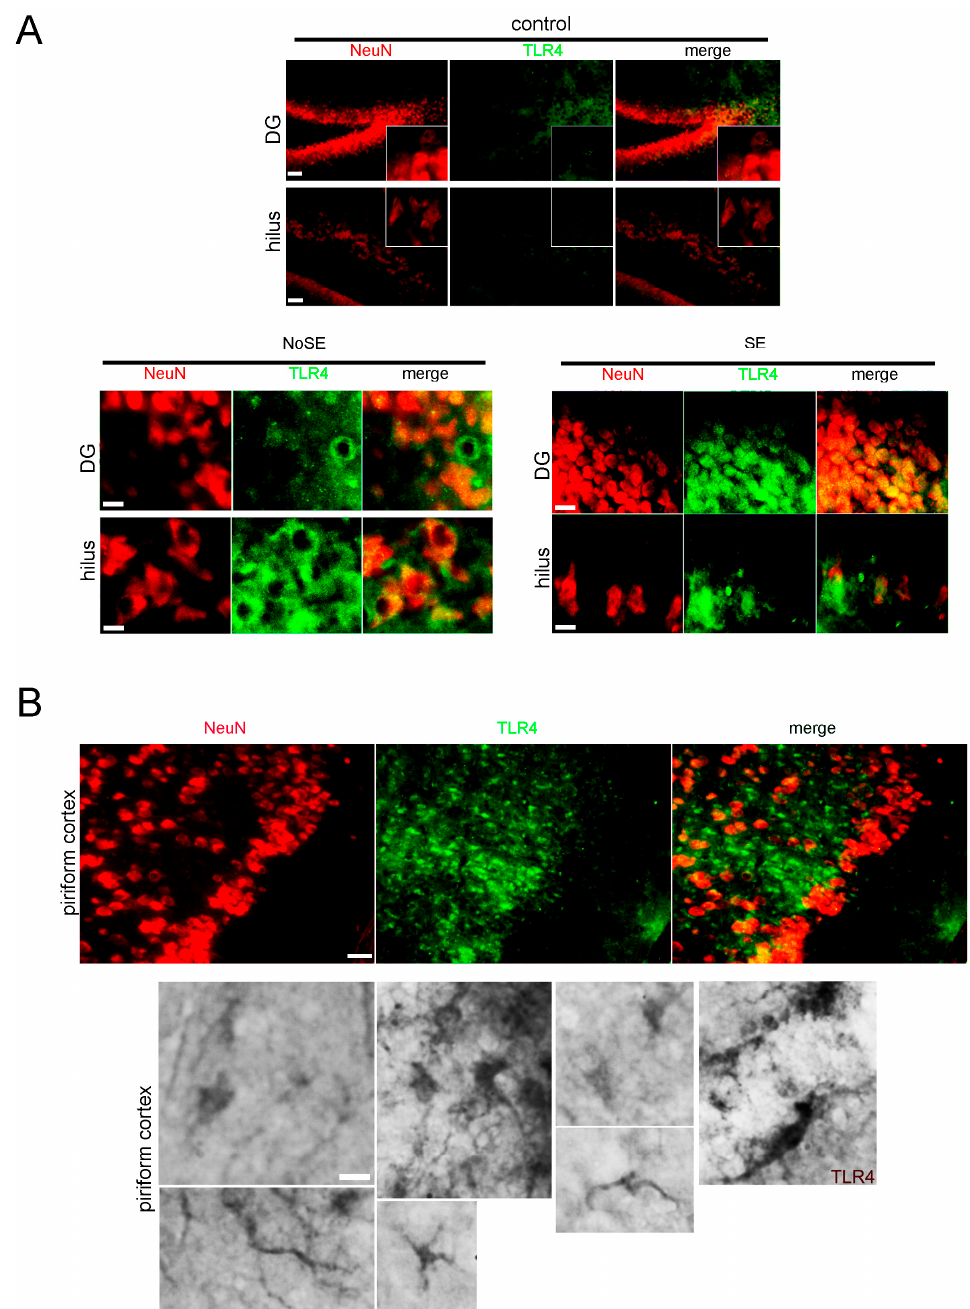
Figure 1. TLR4 expression in the lithium-pilocarpine experimental model of temporal lobe epilepsy (TLE). ( A ) Representative photomicrograph of hippocampal brain tissue sections immunostained for TLR4 (green) and neurons were identified with the NeuN neuronal specific marker (red). No-SE animals were those that reached Racine 1–2, without reaching sustained Racine 3–5 that was considered as status epilepticus (SE). Images were obtained in the hippocampal hilus and dentate gyrus (DG) at 15 days after pilocarpine-induced seizures. Scale bars: 30 μ m (control panel); 15 and 10 μ m (No-SE panel); 30 μ m and 15 μ m (SE panel). ( B ) Upper panel : Representative photomicrograph of piriform cortex brain tissue sections immunostained for TLR4 (green) showing small rounded cells that invaded the piriform cortex that lost NeuN neurons (red) at 21DPSE. Scale bar: 30 μ m. Lower panel : Immunohistochemistry for TLR4 showing the expression in glial cells and neuronal projections from piriform cortex at 21 days post SE (21DPSE). Scale bar: 10 μ m.